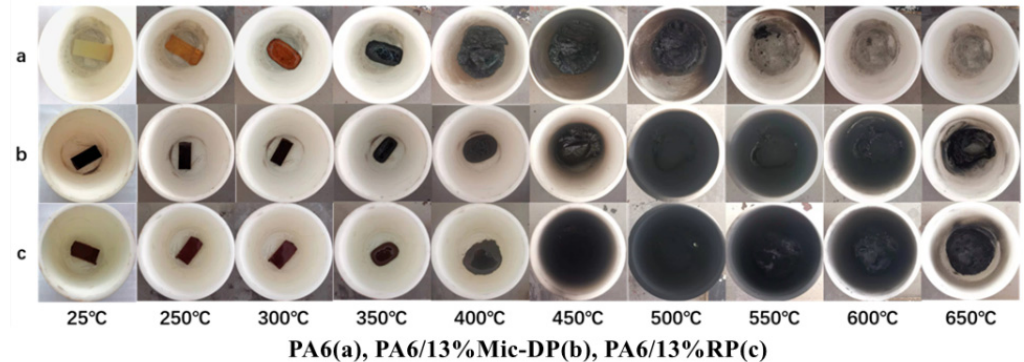
Figure 9. Photographs of PA6 samples at different temperatures.